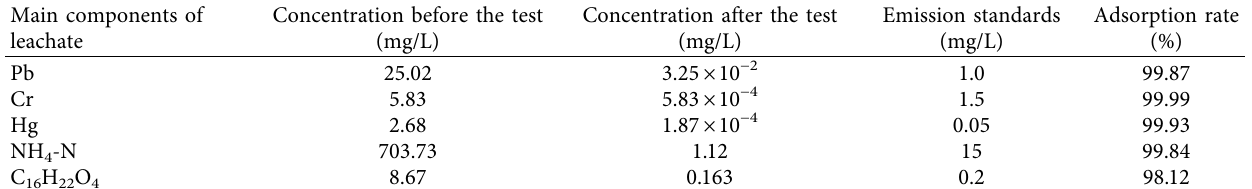
Table 8: Results of leachate adsorption by slurry